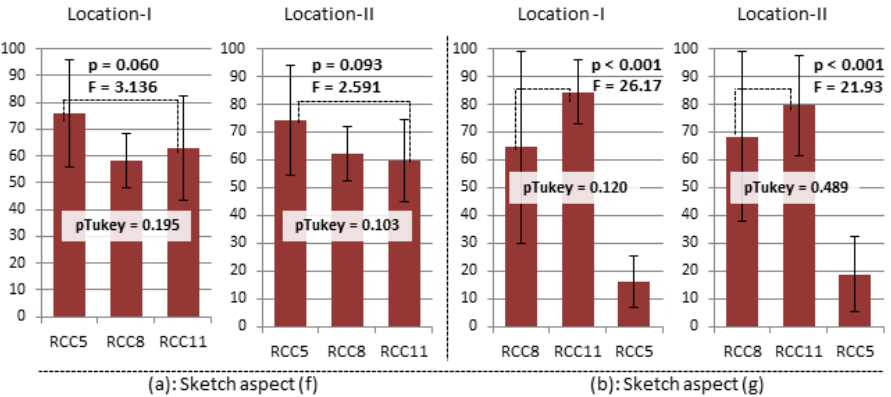
Figure 10: (a) The accuracy rates of matched landmarks and the ANOVA and post-hoc test results across the used representations, (b) the accuracy rates matched city-blocks using the RCC 5 , RCC 8 , and RCC 11